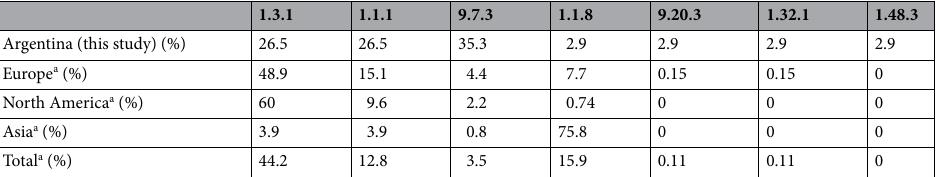
Table 3. Comparison of reported TPA allelic profile frequencies between this study and studies conducted in other continents. a Data according to the PubMLST database 15 . Only the frequencies of fully typed strains were used for calculations.